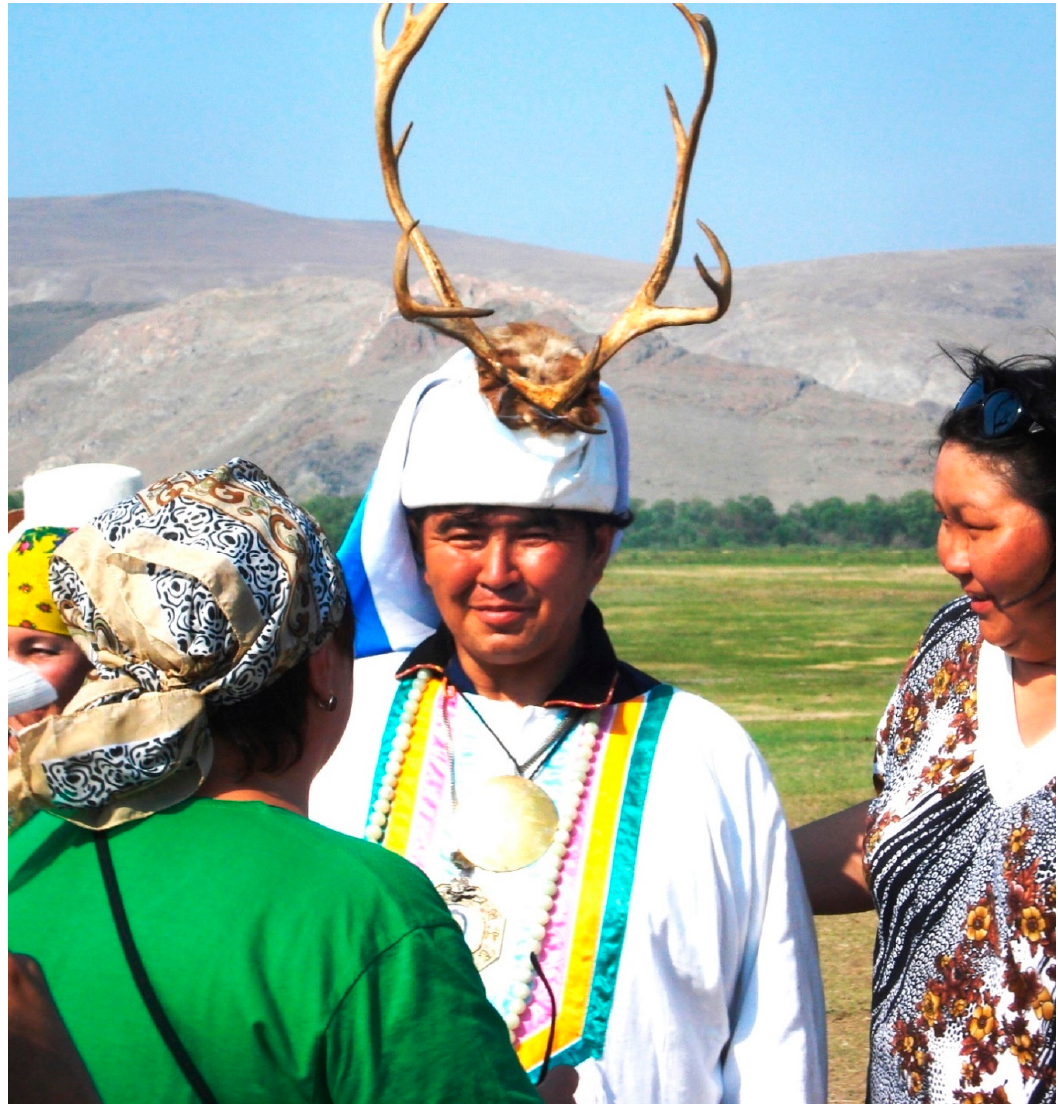
Figure 10. Buryat shaman Valentin Khagdayev after descending from the hill “Yord” after performing the prayer ritual on its top during the worshippers’ “yokhor” dance around it (2011). Photo: Stefan